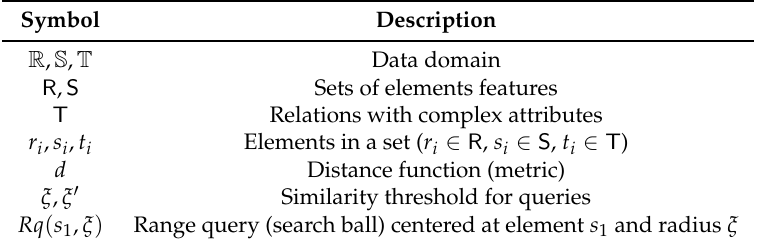
Table 1. Table of